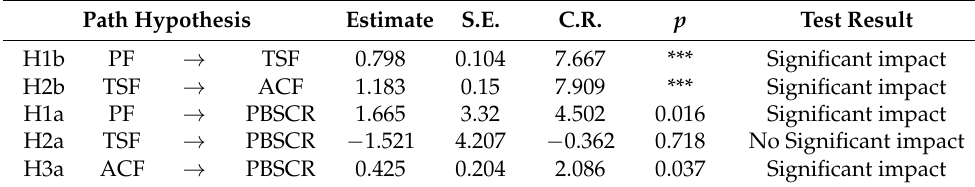
Table 6. Intrinsic quality verification factor